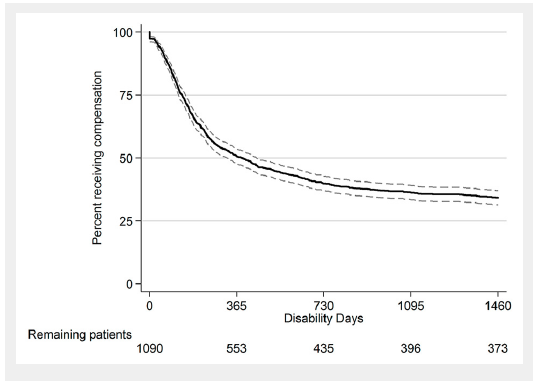
Figure 1 Kaplan-Meier survival function with 95% confidence interval.